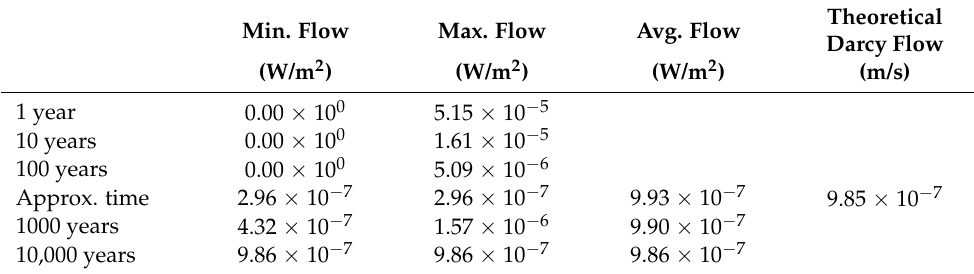
Figure 7. Zoomed-in flow rates from Figure 6 for time intervals of 100 years to 10,000 years to show the transition from transient to steady-state flow. The FEA model is represented by the data points, and the analytical model is shown by the lines/dashes. Table 2. Minimum, maximum, and average flow across the sample at the specified time intervals compared to the theoretical Darcy flow (Equation (4)) from the parameters in Table 1. Note that if the sample has a minimum flow of zero, the average flow was not